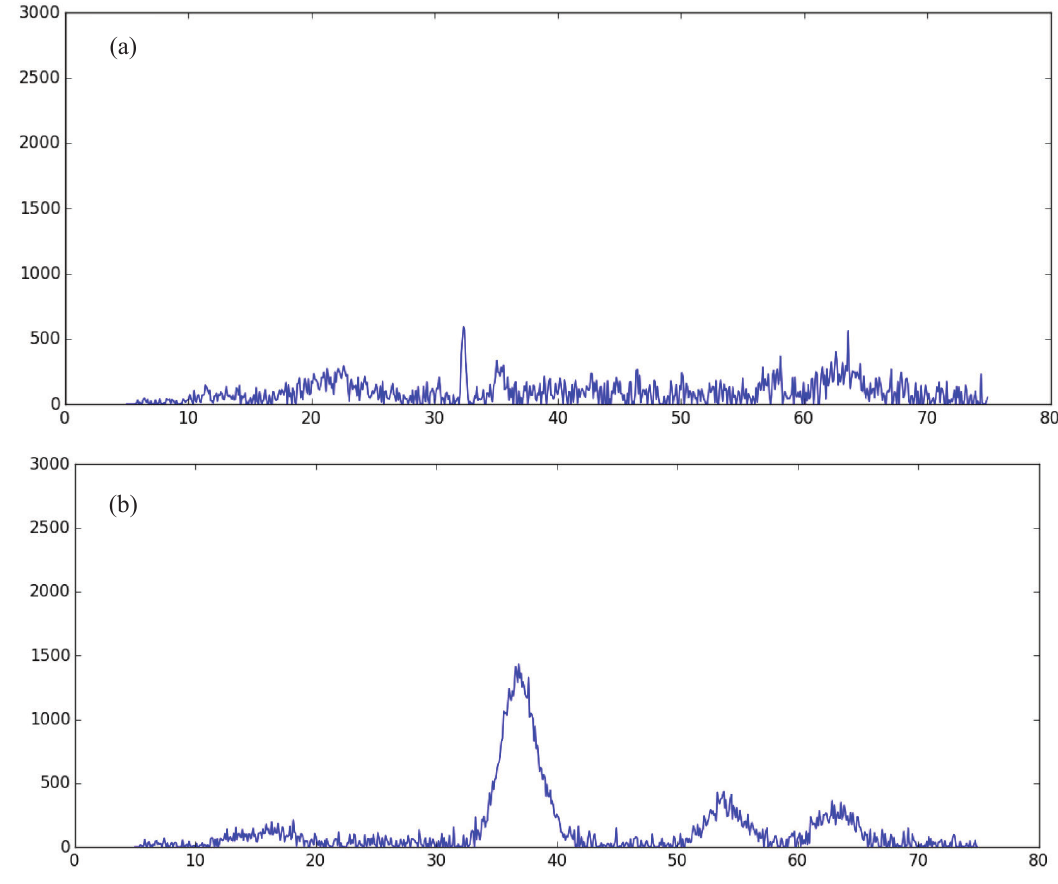
O hydrogel (a) and MHN adsorbent (b) 3 4